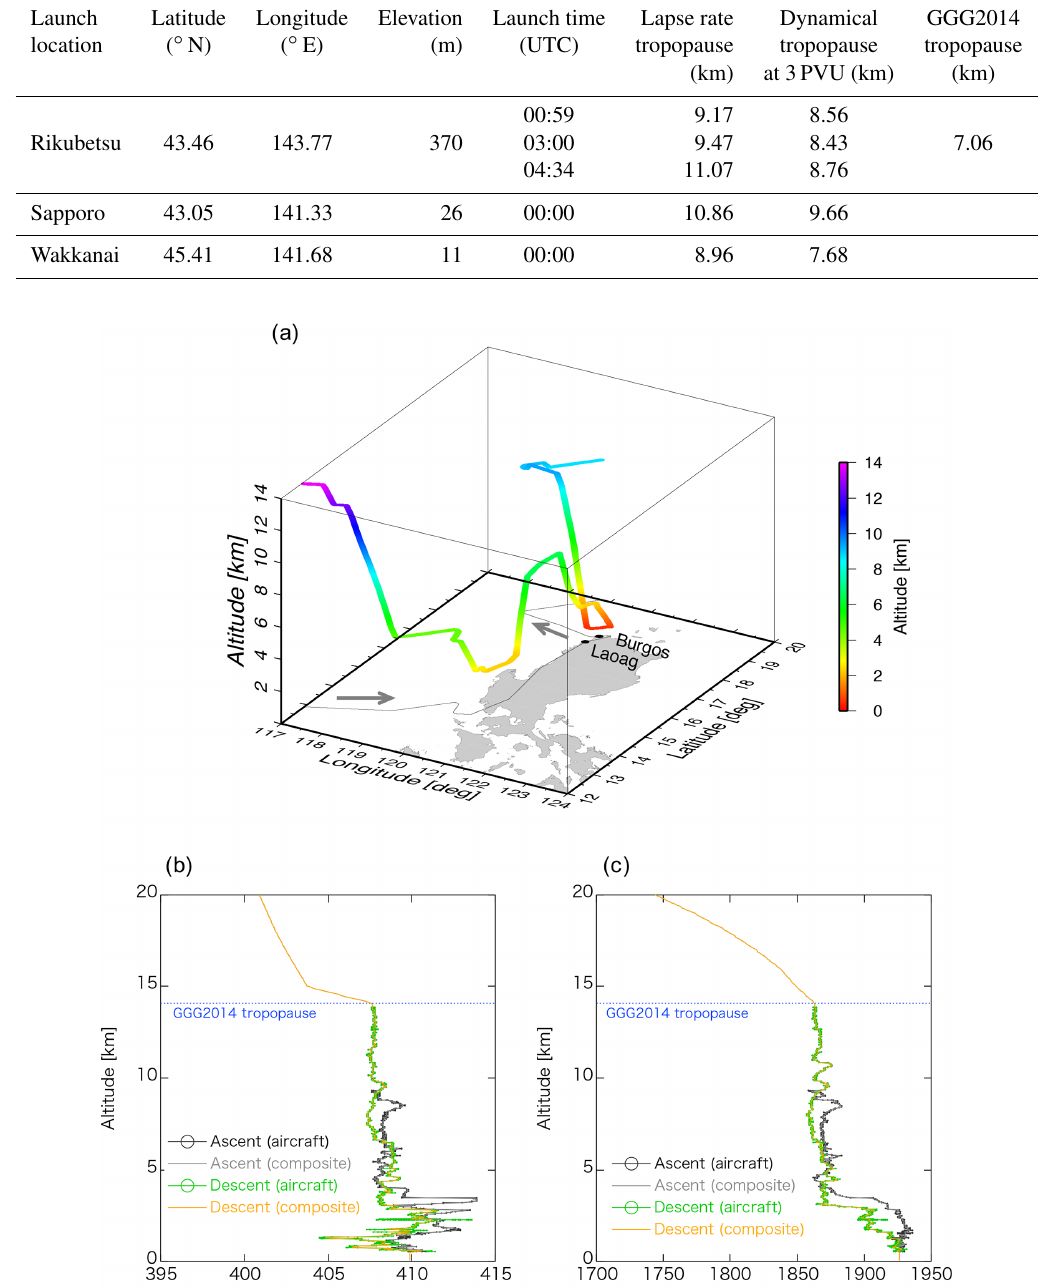
Figure 3. (a) Aircraft flight track over the Philippines on 12 March 2018 during the EMeRGe campaign. The arrows indicate the flight direction, and the thin solid line represents the flight track projected on the ground. (b, c) The descending (green) and ascending (black) CO 2 and CH 4 mole fraction profiles measured by airborne instruments. The composite profiles for the descent (yellow) and ascent (gray) flights that are used for calculating their column-averaged dry-air mole fractions and the GGG2014-derived tropopause over Burgos (blue) are also